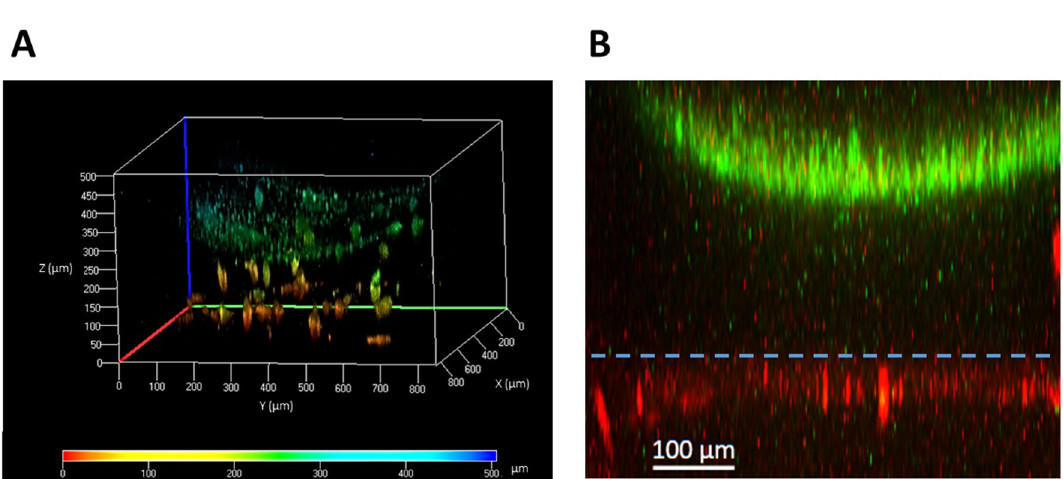
Figure 9. ( A ) Confocal image of a bilayer dermo-epidermal equivalent generated in the UC of the microfluidic device using the parallel flow method. The colour code indicates the height of the cells (Z axis). The lower, reddish objects correspond to hFBs and the green and smaller ones, on top of the hFBs, correspond to hKCs. ( B ) Confocal image of a three-layer construct composed of a layer of red fluorescent cells (HaCaT-RFP) seeded under the porous membrane (denoted with blue dashed line), an acellular fibrin hydrogel generated by parallel flow method and an epithelial layer composed of green-fluorescent cells (HaCaT-GFP) seeded on top of the